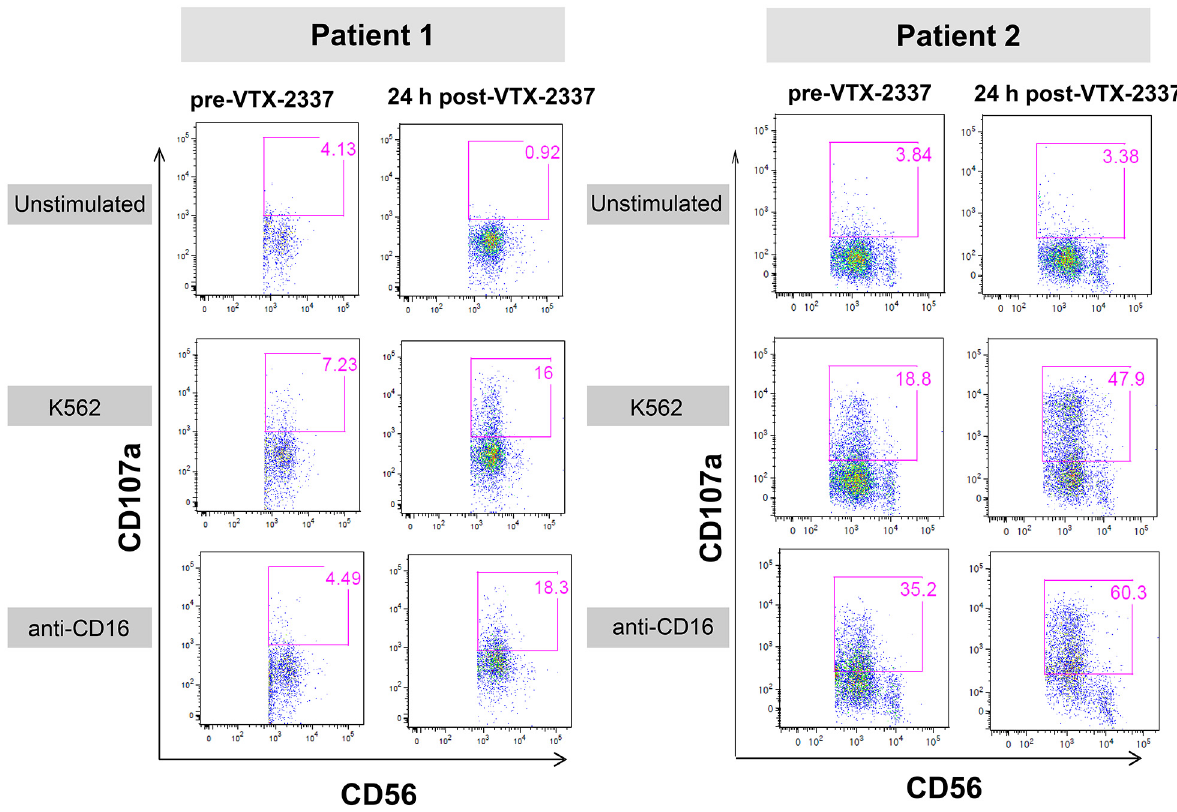
Fig 7. Administration of VTX-2337 to SCCHN cancer patients enhances NK cell degranulation. Representative FACS plots from two patients illustrate NK cell activation measured by increased CD107a expression 24 h following the administration of VTX-2337 (3.0 mg/m 2 ) compared to pre-treatment. Freshly isolated PBMC from each patient were unstimulated (negative control), or were stimulated with K562-15mb-41BBL cells or plate-bound anti-CD16